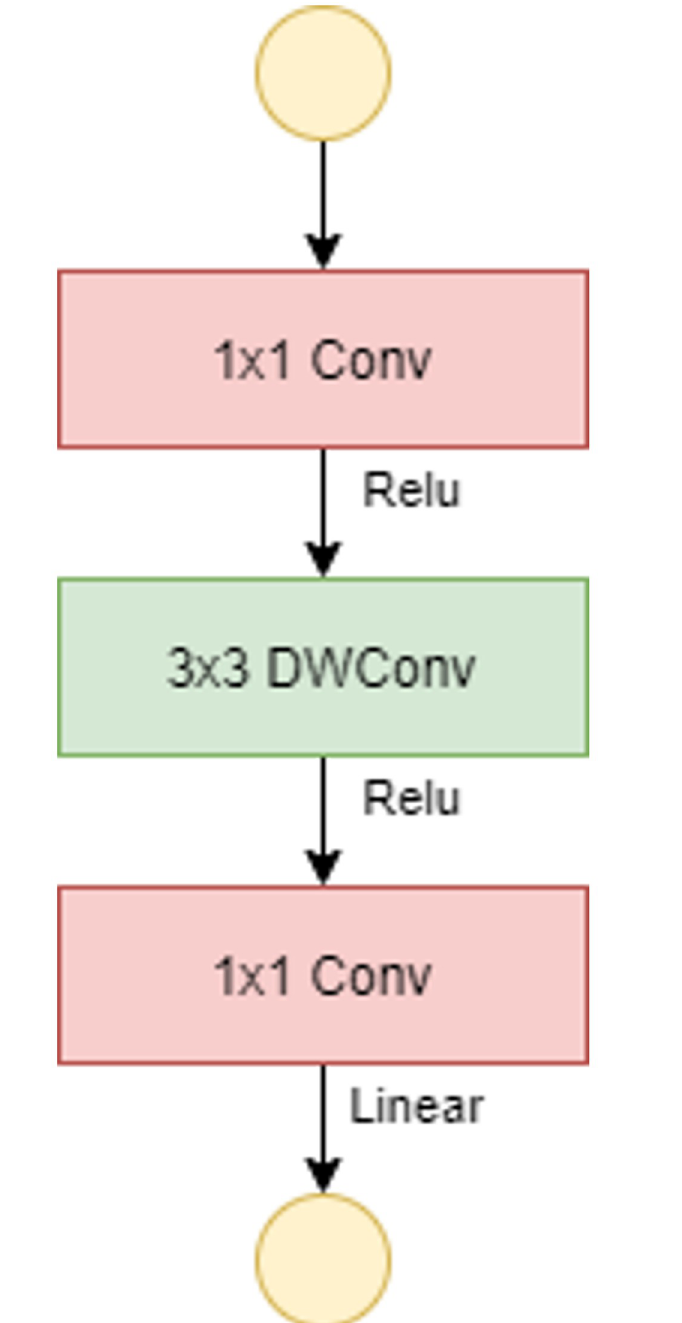
Fig 5. Bottleneck residual block of MobileNetv2 with stride =